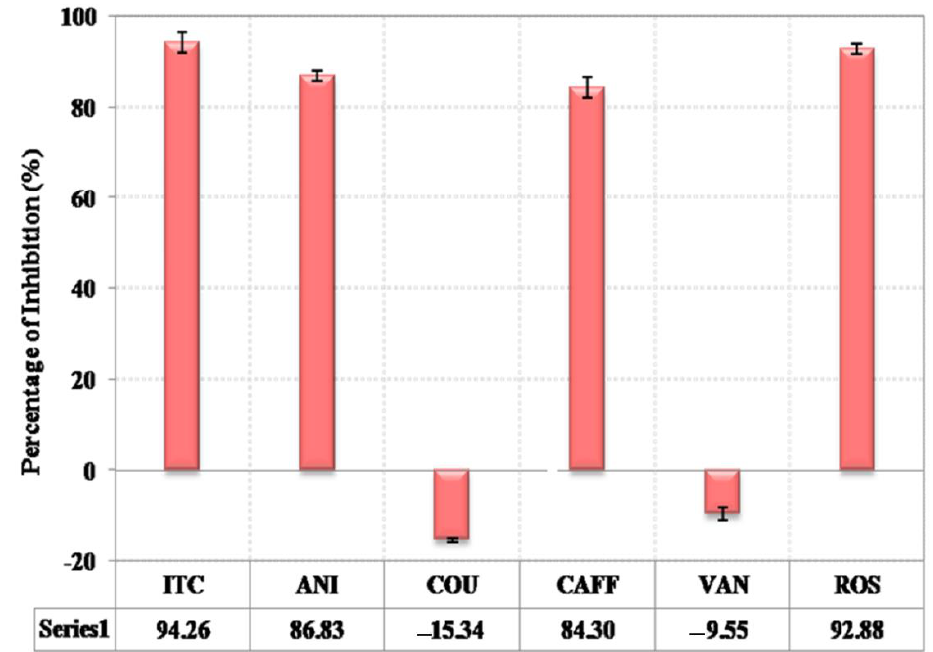
Figure 5. Percentage Inhibition of H. pinifolia -derived compounds in the ICL 1 enzyme inhibition assay.